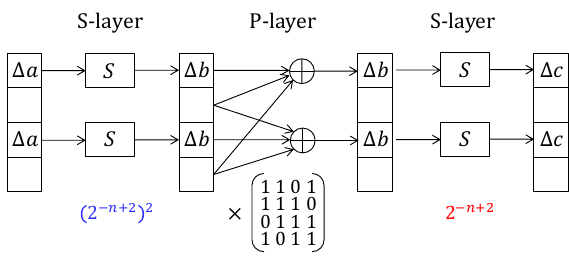
Figure 6: Overview: 2-round characteristic in SPN with single